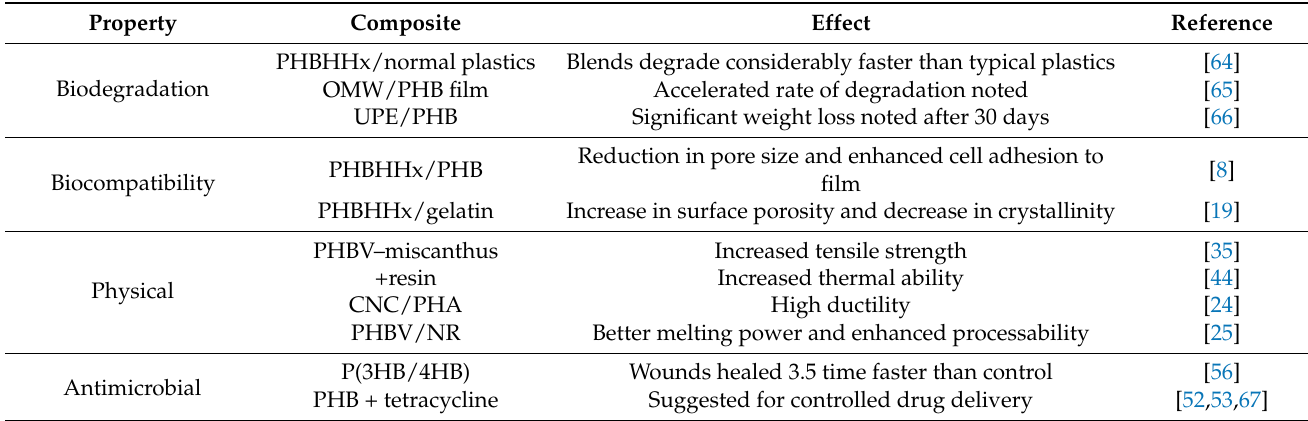
Table 1. This table shows a comprehensive summary of this article in a tabular